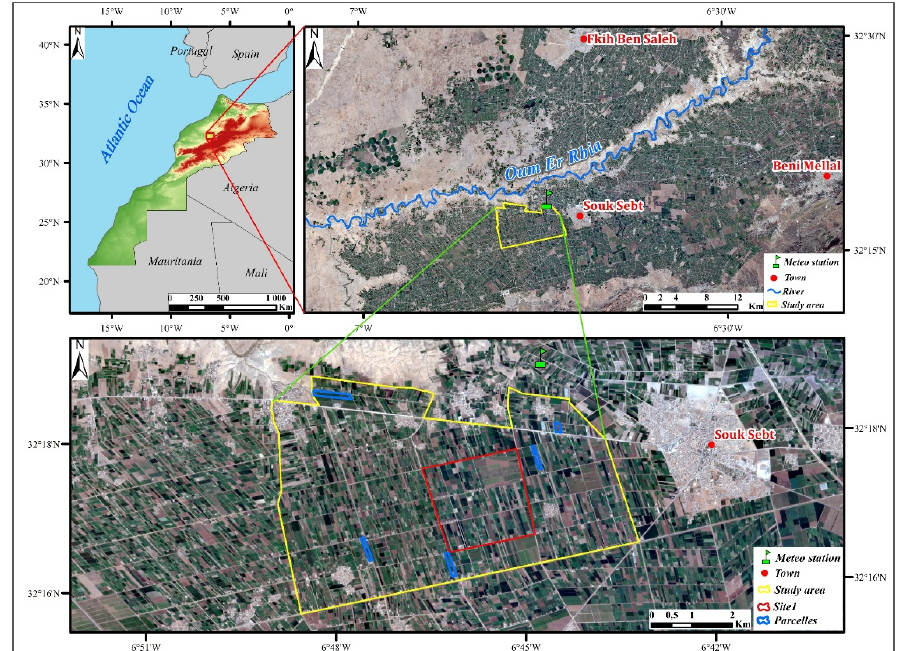
Figure 1. Location of the study area with Sentinel-2A images as a basemap.